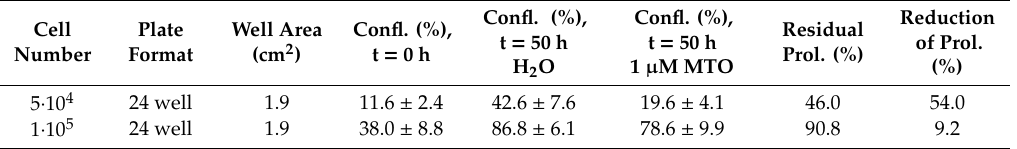
Table 2. Confluence of 1 · 10 5 cells compared with 5 · 10 4 cells seeded in 24-well plates as monolayers. Shown are the mean values of 4 wells (with 4 pictures per well) with standard